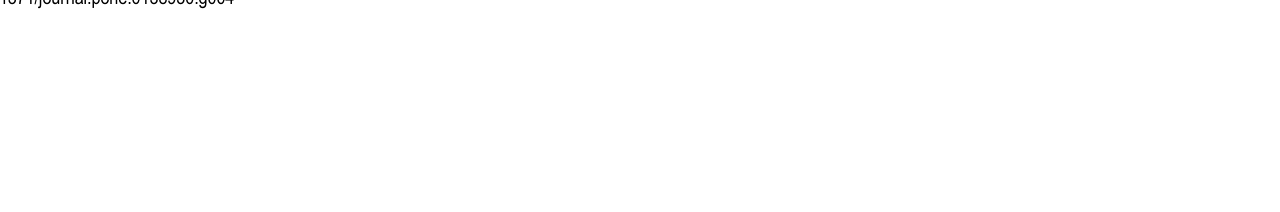
PLOS ONE | DOI:10.1371/journal.pone.0138930 October 8,